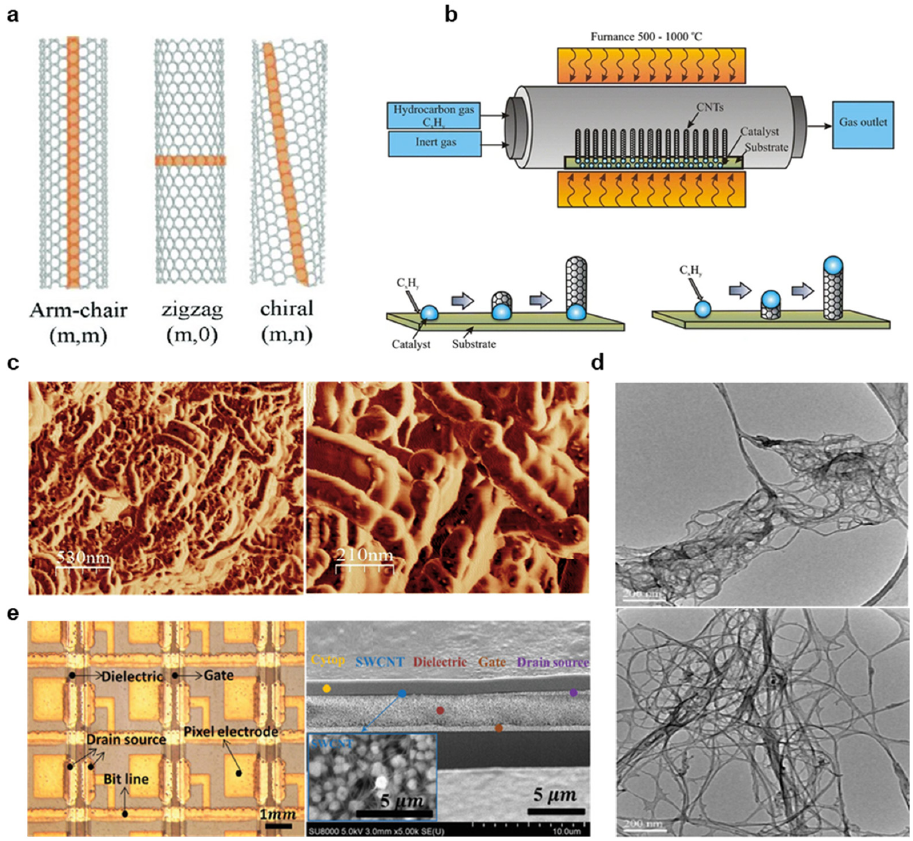
Figure 9. Carbon nanotubes for high throughput bioelectronics printing. ( a ) Armchair, zigzag, and chiral CNT geometries, each of which exhibits unique material properties. (reprinted with permission from Physica E Low Dimens. Syst. Nanostruct . (2014), 59:186–191. Copyright 2014, Elsevier) ( b ) Schematic representation of the CVD process for CNT synthesis, with illustrations of the base growth (bottom left) and tip growth (bottom right) CNT synthesis methods. (reprinted with permission from Chem. Biol. Technol. Agric. (2016), 3(17). Copyright 2016, Springer Nature) ( c ) AFM images of printed MWCNTs at different magnifications. (reprinted with permission from RSC Adv. (2017), 7, 44076–44081. Copyright 2017, RSC). ( d ) TEM images of SWCNTs in an SDS solution after sonication for 4 h (top) and 6 h (bottom). (reprinted with permission from J. Surf. Eng. Mater. Adv. Technol. (2013), 3, 6–12. ( e ) Image of pixels in a roll-to-roll gravure printed TFT-active matrix with 10 PPI resolution (left) and cross-sectional FIB-SEM of printed SWCNTs on the printed dielectric (right). (reprinted with permission from Adv. Electron. Mater. (2020), 6, 1901431, Copyright 2020,